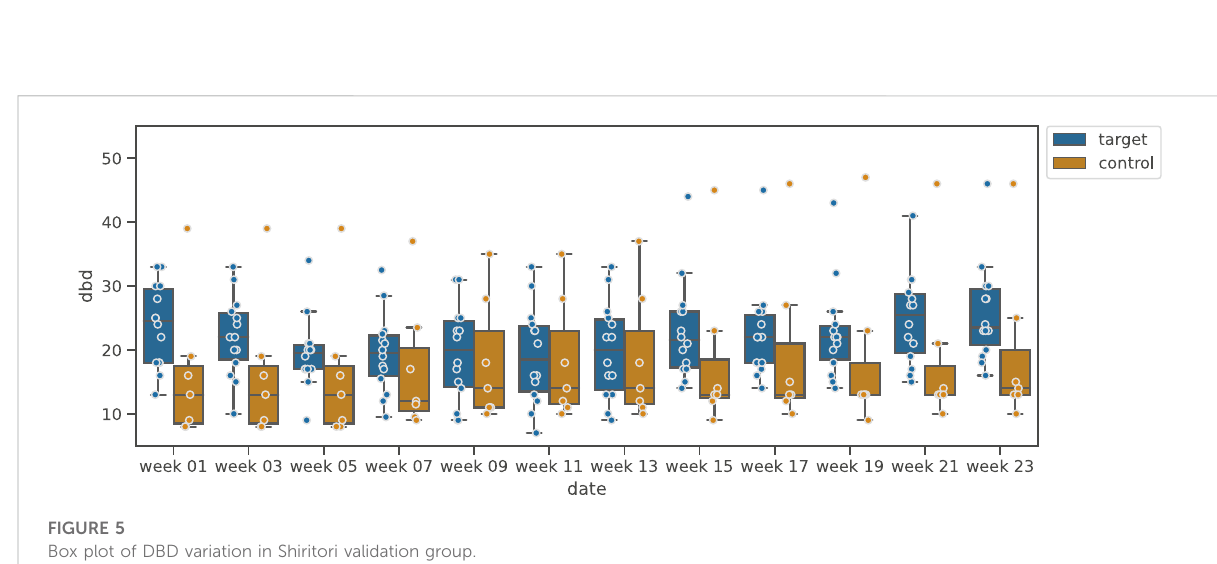
FIGURE 4 Box plot of MMSE variation in Shiritori validation group.